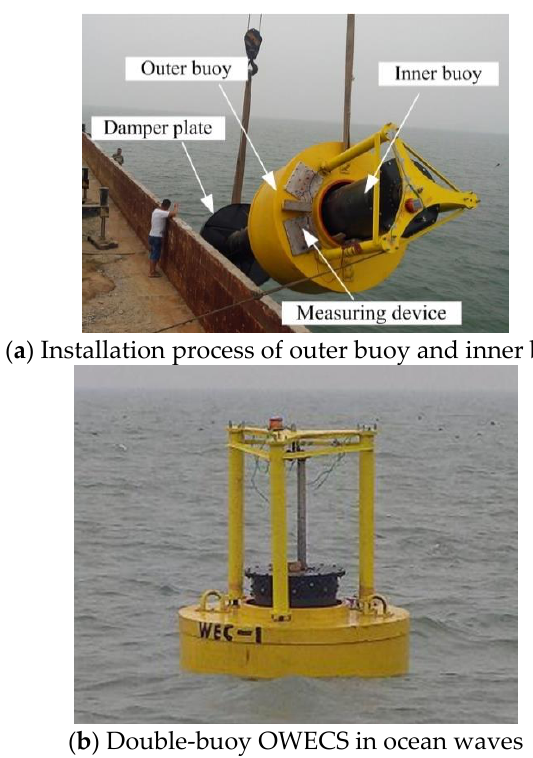
Figure 7. The installation process and operation of OWECS.